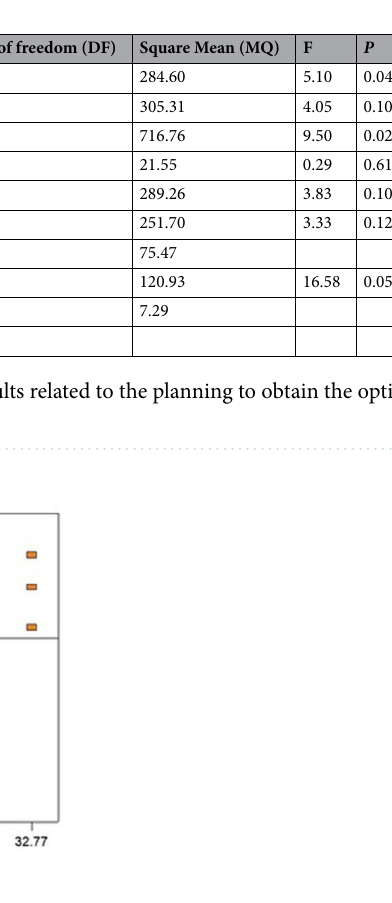
Figure 4. Graph of residues versus predicted for the regression of the DPPH statistical analysis, of the aqueous extract obtained via Soxhlet for the second planning